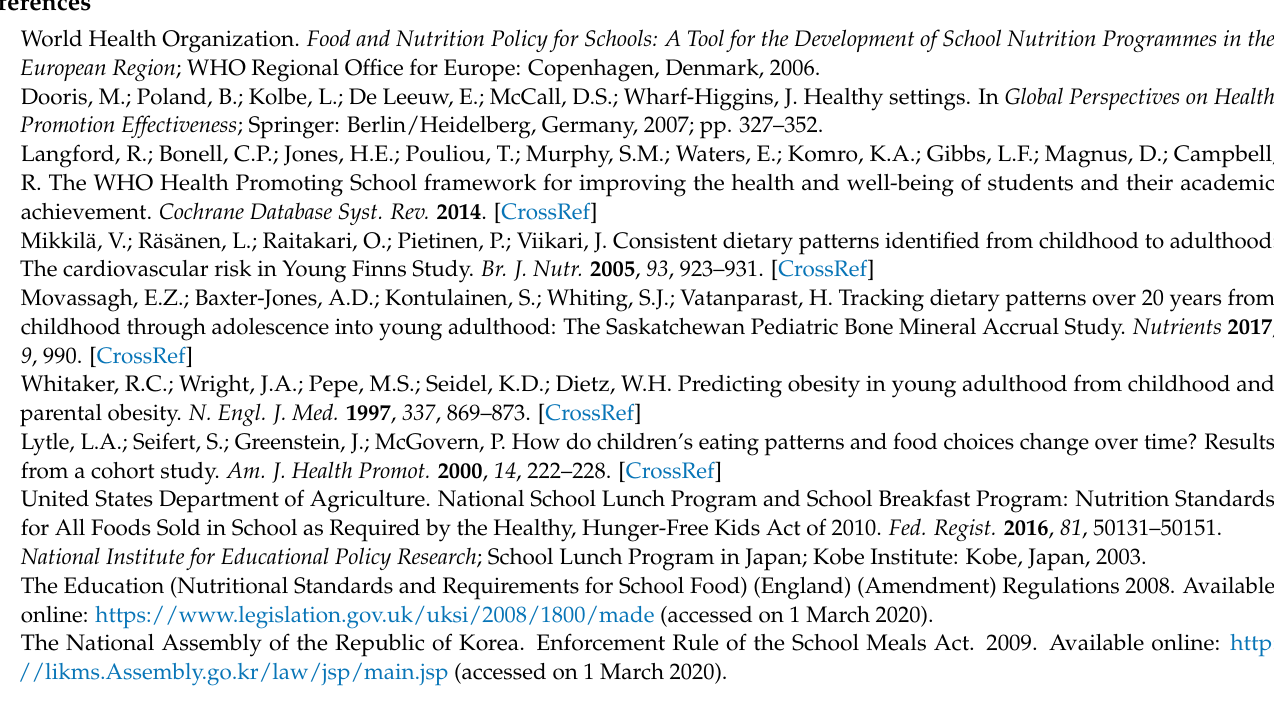
Table S3: Quality Assessment of Cohort and Quasi-experimental Studies based on the Newcastle Ottawa Quality Assessment